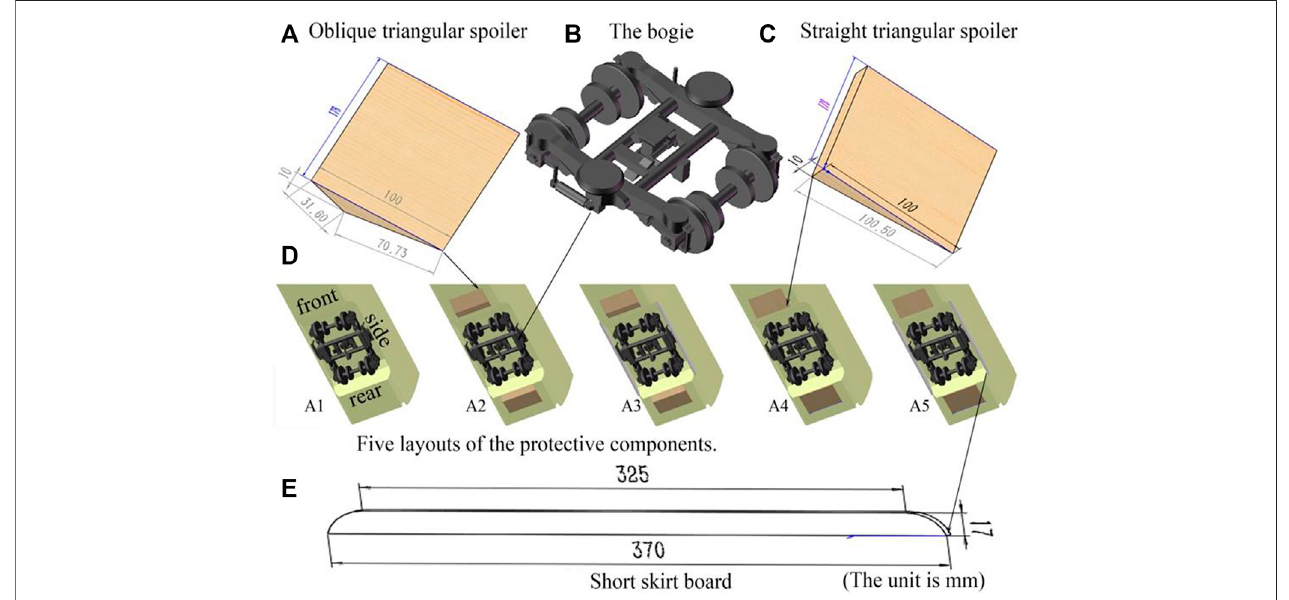
FIGURE 3 | Protective components [ (A) oblique triangle spoiler, (B) the bogie and (C) straight triangle spoiler, and (E) short-skirt board] and their fi ve layout with arrows pointing to the component enlarged (D) .